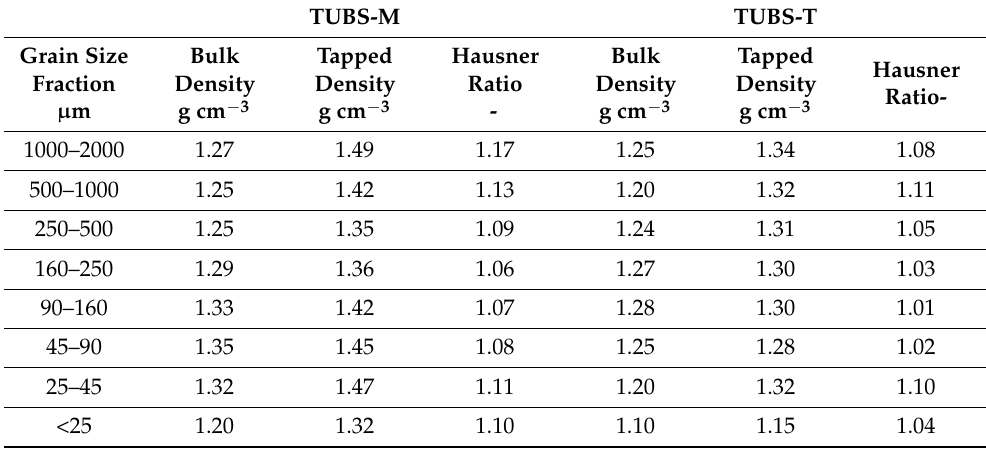
Table A1. Bulk density, tapped density, and Hausner ratio of the grain size fractions of both regolith simulants.